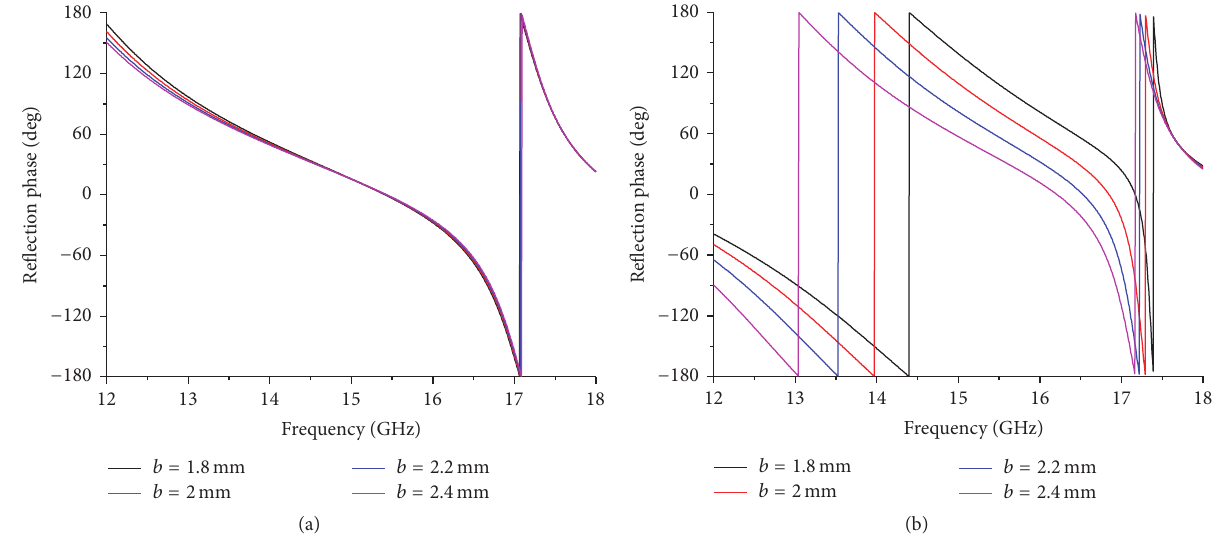
Figure 7: Reflection phase for various values of 𝑏 : (a) under major axis polarized incidence; (b) under minor axis polarized incidence.